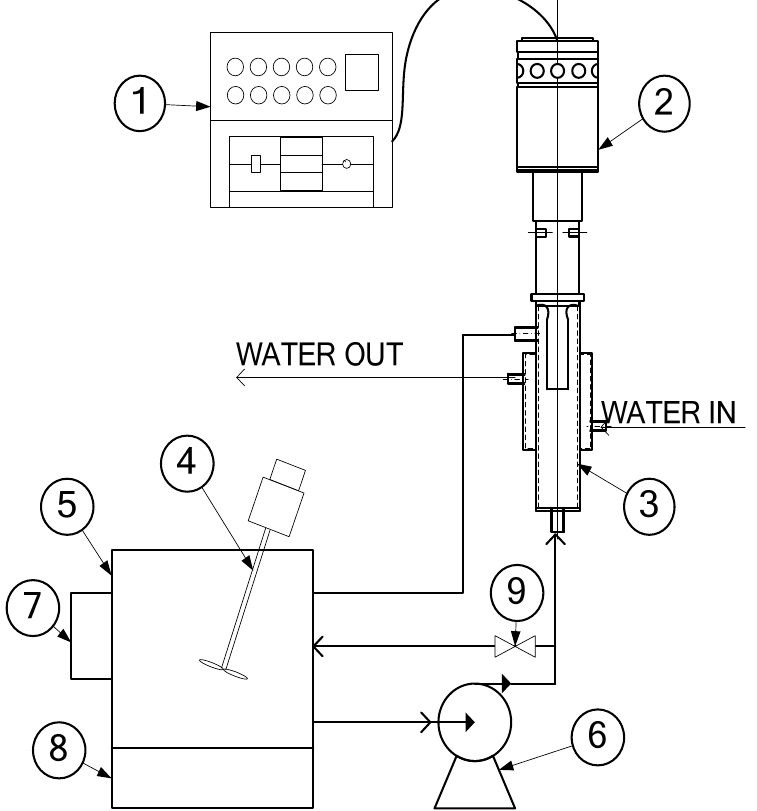
Figure 2. Schematic of ultrasonic irradiation equipment: (1) Power supply and ultrasonic generator; (2) Transducer assembly and ultrasonic horn; (3) Reactor-cup chamber; (4) Agitator; (5) Oil-supply tank; (6) Oil-circulation pump; (7) Heating oil tank; (8) Heater; (9) By-pass.